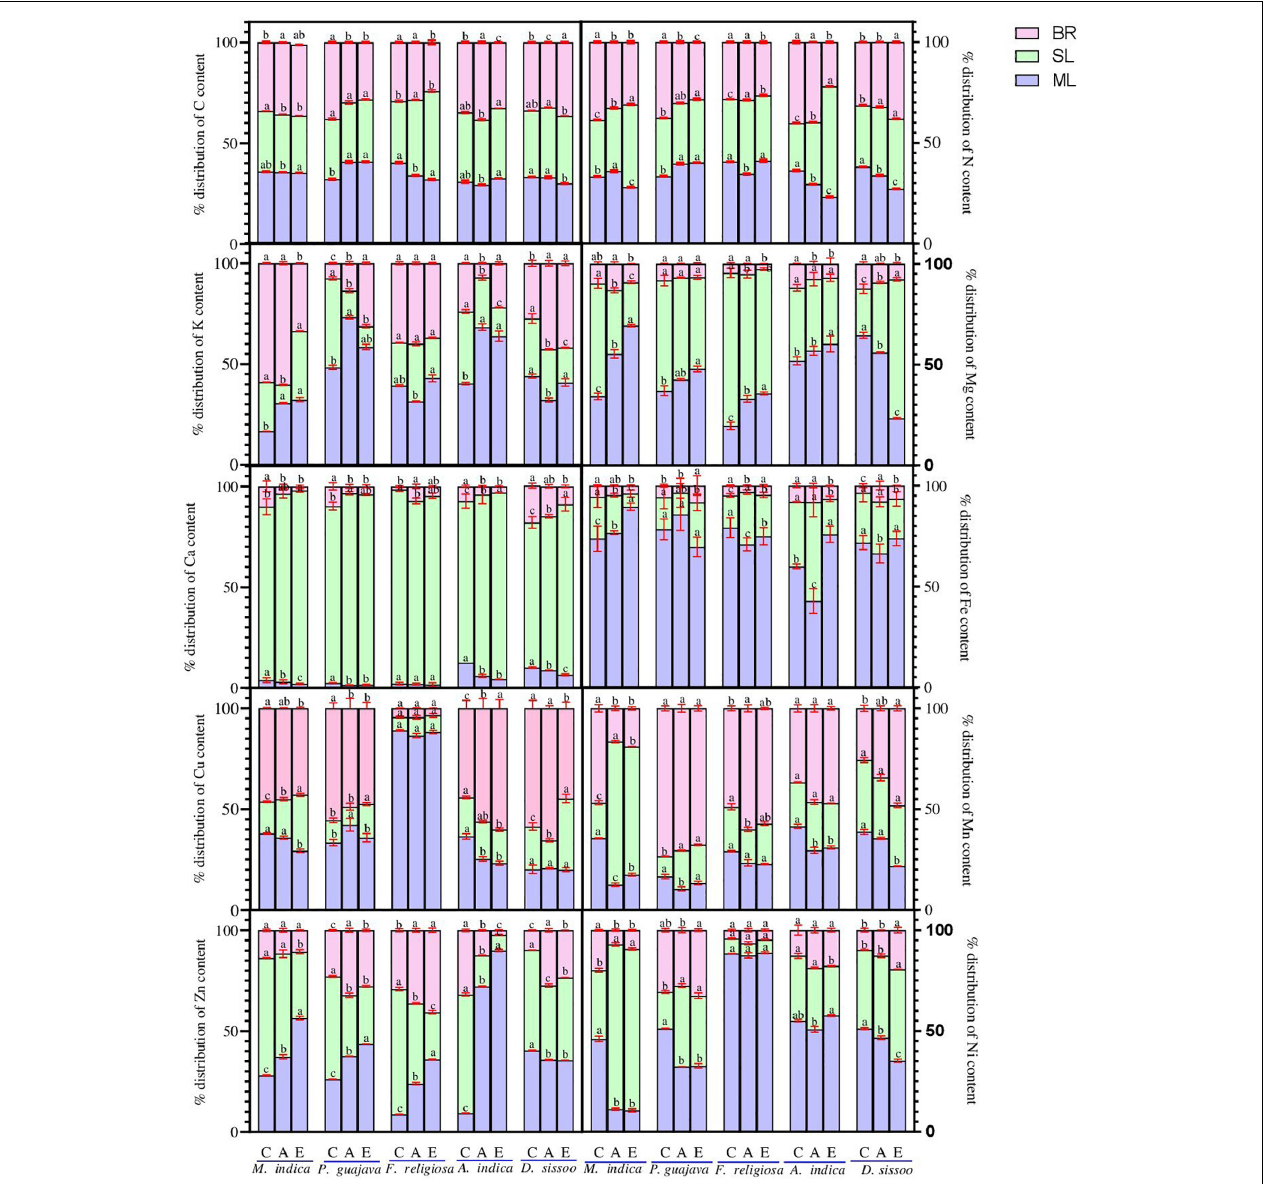
FIGURE 4 | The nutrient allocation pattern of different tree species under different PM treatments. Different lowercase letters indicate a significant difference between the treatments within species ( p < 0.05). BR, branch; SL, senesced leaf; ML, mature leaf.